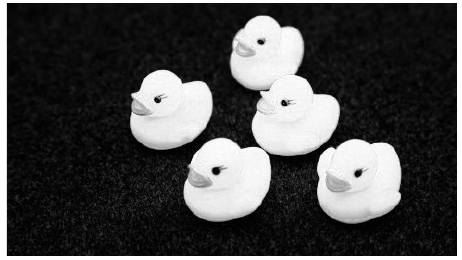
Figure 4. Convex combination result after defuzzification.